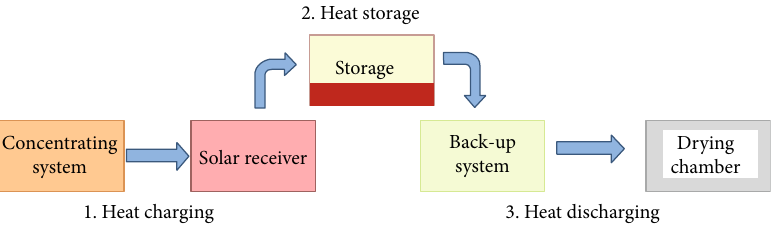
Figure 3: Utilization of heat energy.